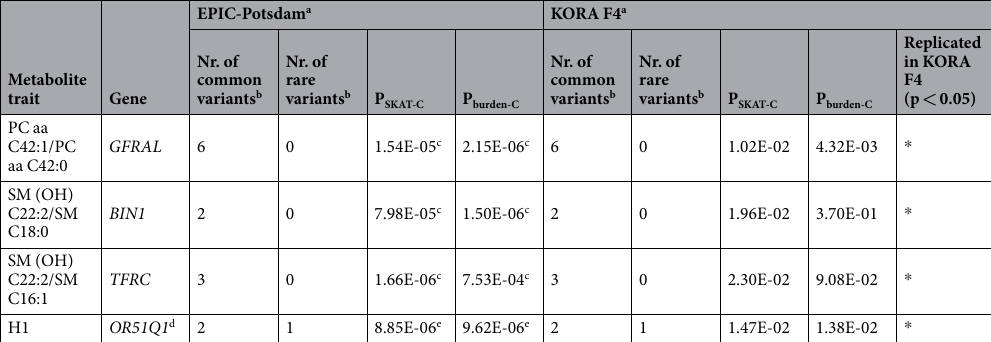
Table 2. Gene-based association with metabolite traits using SKAT and burden test in EPIC-Potsdam and replicated in KORA F4. a EPIC-Potsdam: n = 2200–2202, KORA F4: n = 2688–2692; analyses were adjusted for age and sex. b Rare variants with MAF